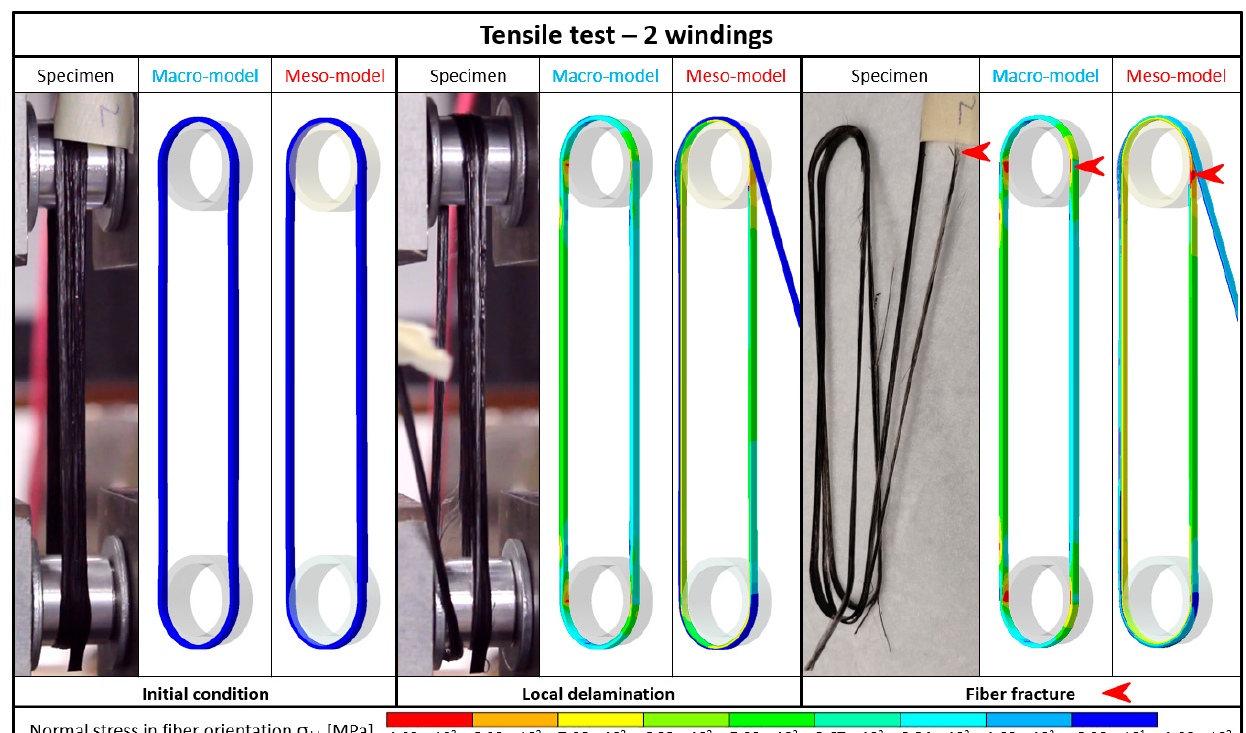
Figure 16. Deformation and failure behavior of simple loops with two windings (specimens and models).